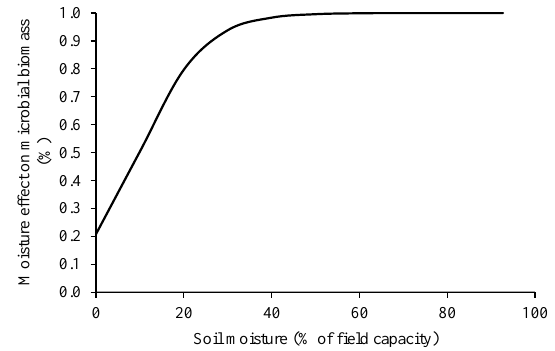
Figure 9. Soil moisture dependence of the modifier of microbial death rate due to water limitation (Ku) used in ForPRAN model simulations (source: the equation used in the Ku modifier was pa- rameterized with data presented in Sato et al., 2000).